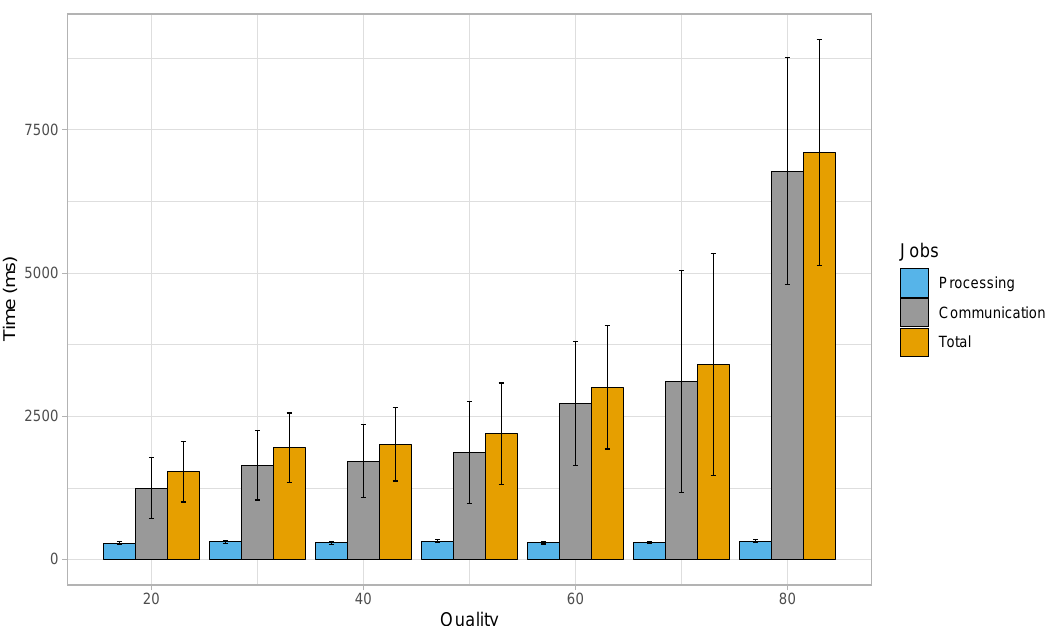
Figure 12. Delay when using a cellular network to process images of HD resolution by a cloud